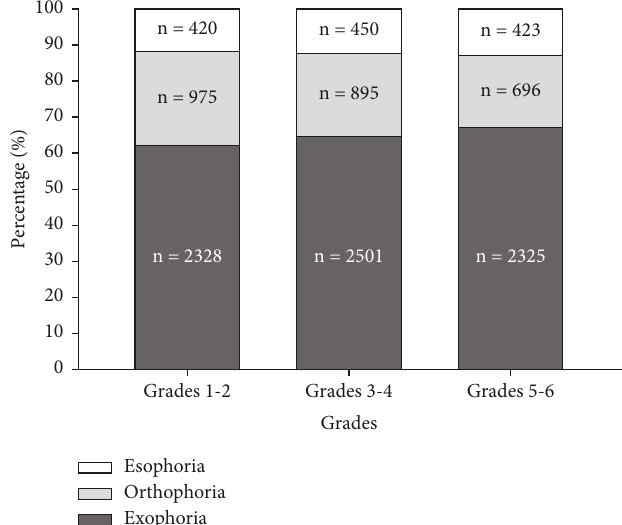
Figure 1: Distribution of different types of near heterophoria according to grade level.